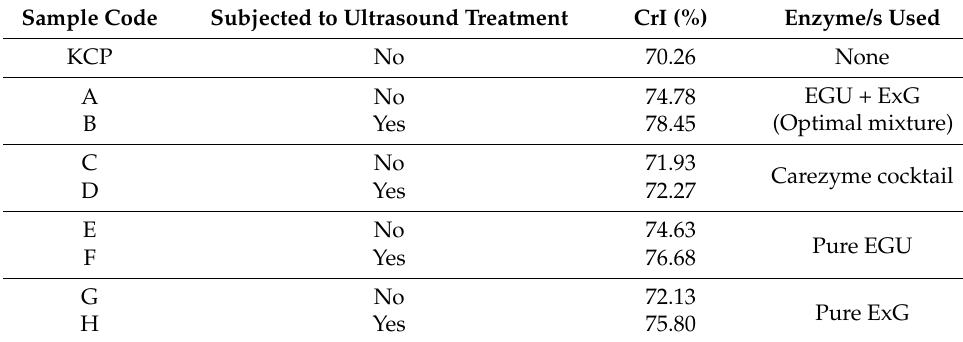
Table 3. Crystallinity indices of validation